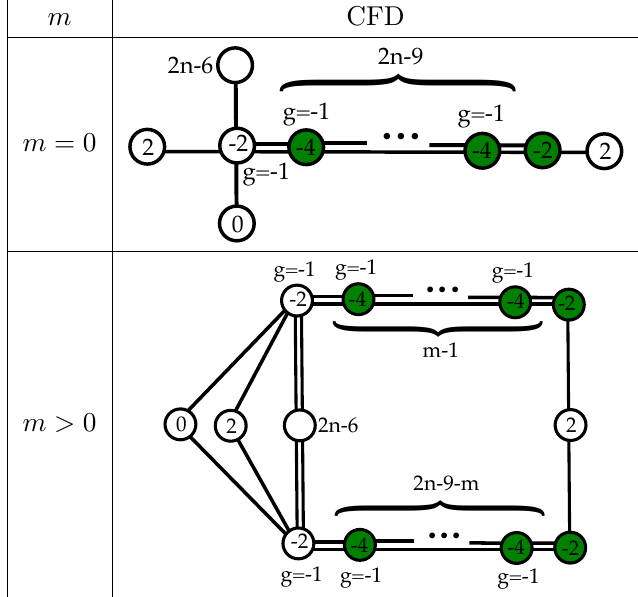
Table 11. CFDs for so (2 n ) on a ( (cid:0) 4)-curve in the description on the tensor branch in terms